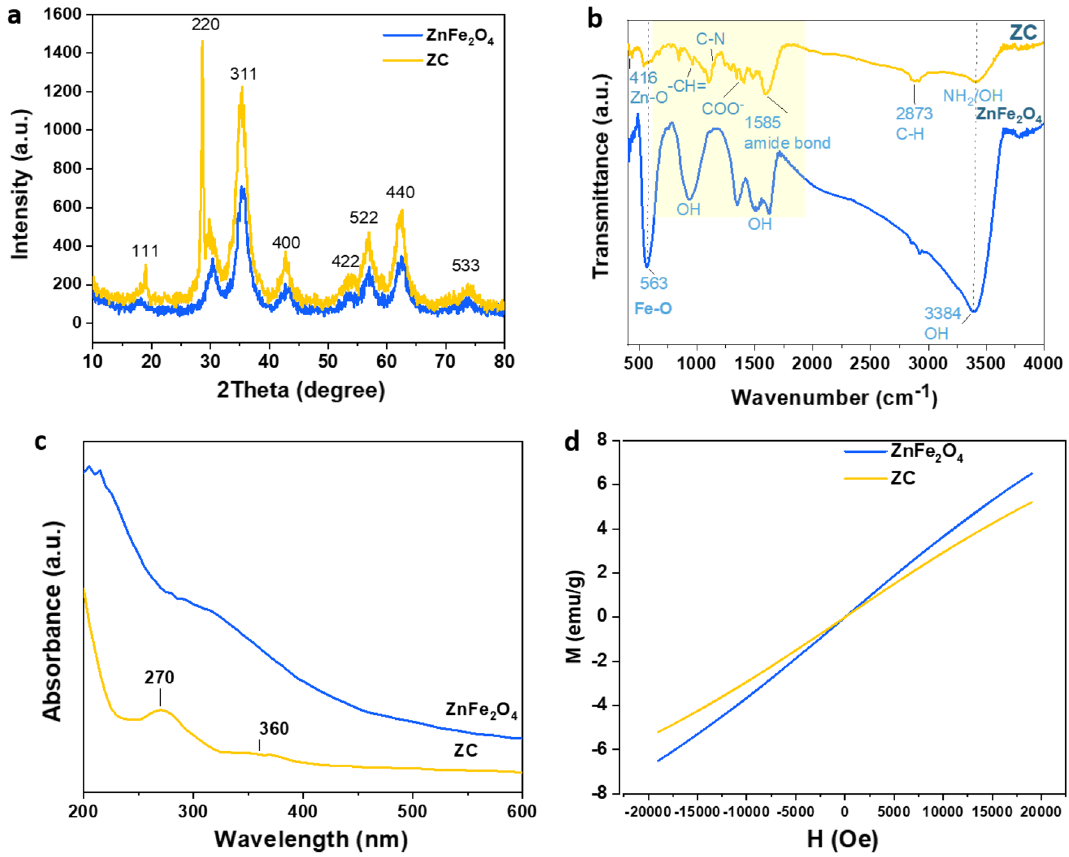
Figure 2. Structural characterization of the synthesized ZnFe 2 O 4 and ZC: ( a ) XRD pattern, ( b ) FTIR spectrum, ( c ) UV–Vis absorption spectra, and ( d ) magnetization curve of ZnFe 2 O 4 and